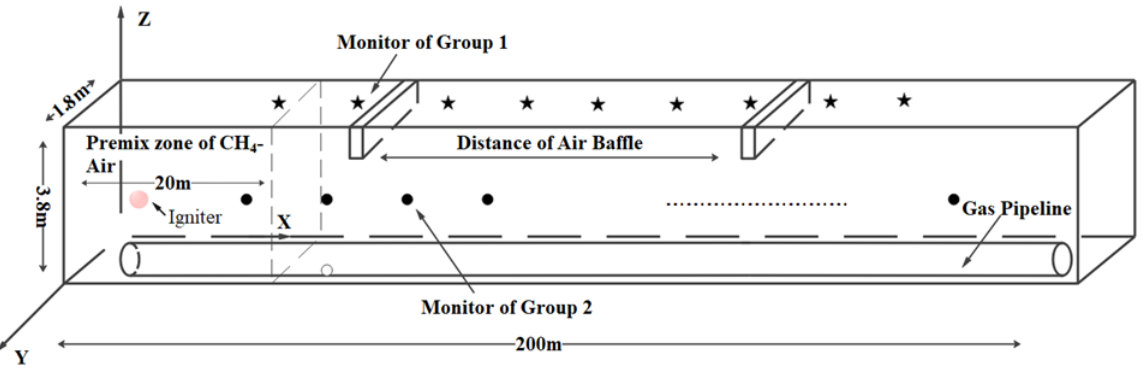
Figure 3. Three - dimensional diagram of the explosion model. Figure 3. Three-dimensional diagram of the explosion